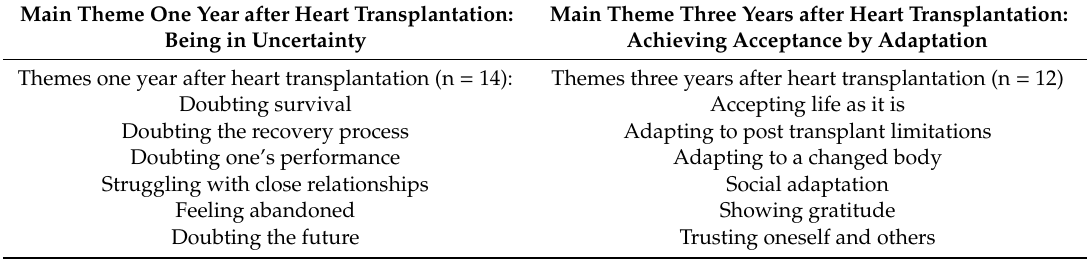
Table 4. The change in the meaning of being a heart recipient from one year to three years